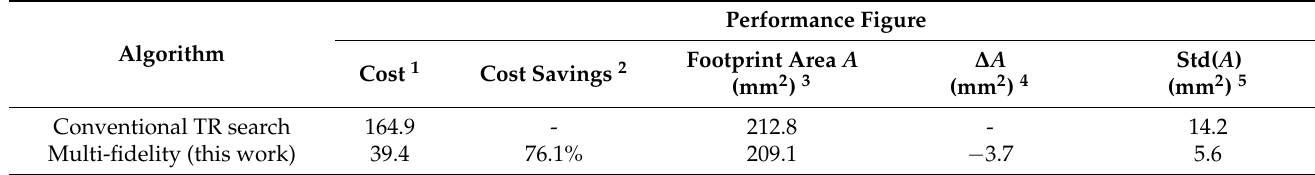
Table 4. Numerical Results for Antenna II.